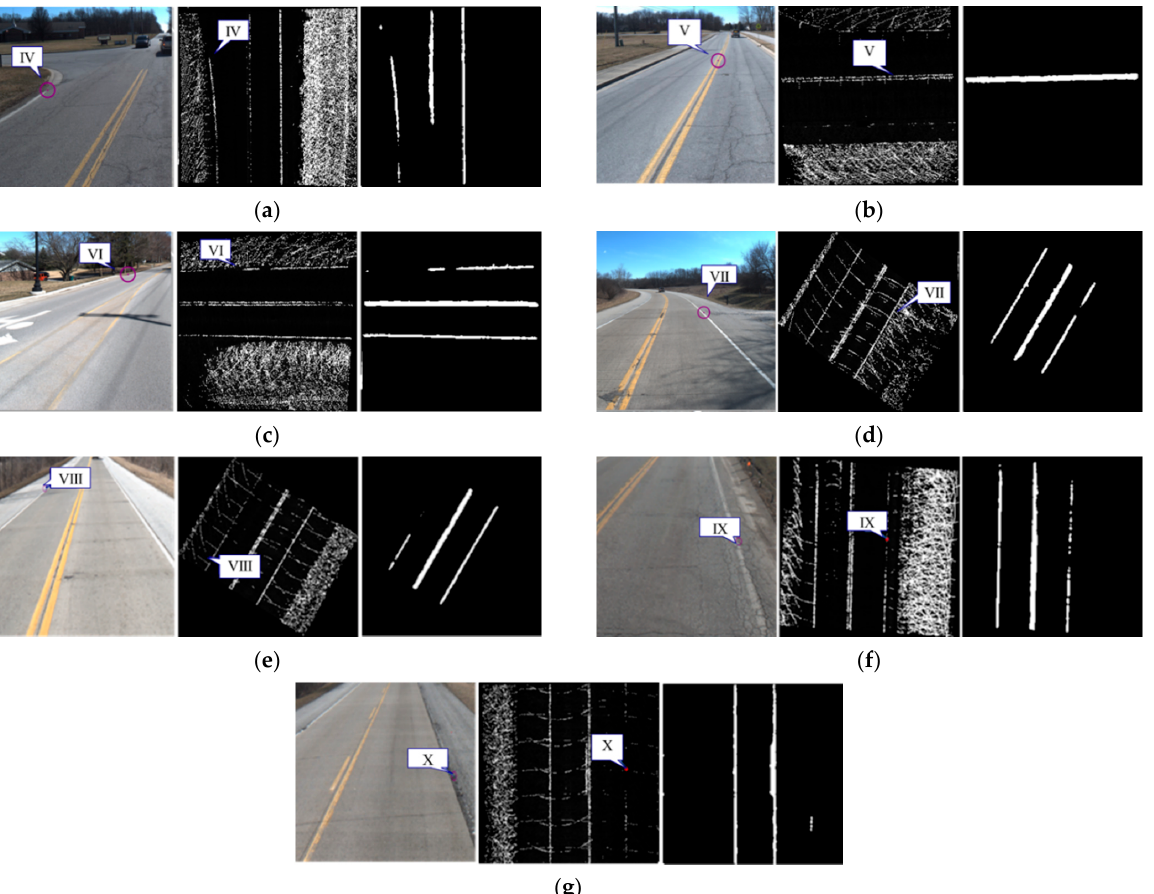
Table 7. Intensity profile difference statistics for WB and EB segments (length: 4.6 miles).